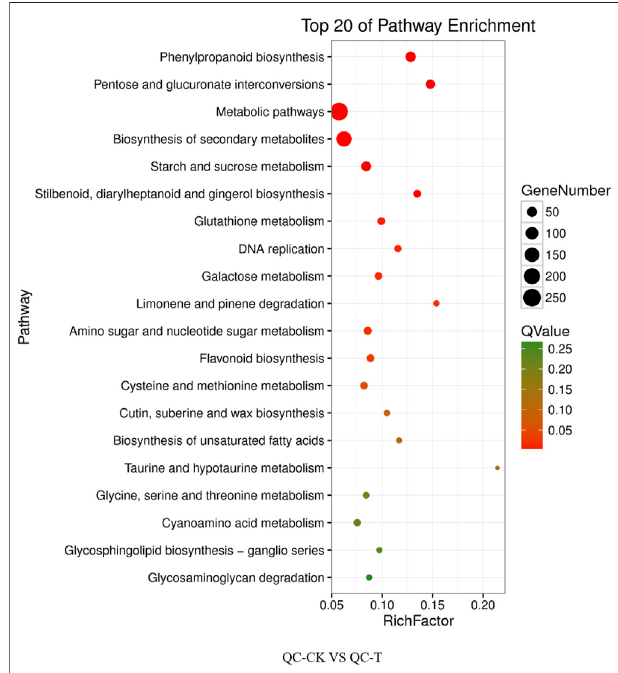
FIGURE6| KEGGpathway ofcuttingtea plantsunderdrought onday0 and day 20. QC, Cutting tea plant. CK: Cutting samples treated with drought for 0 days, T: Cutting samples treated with drought for 20